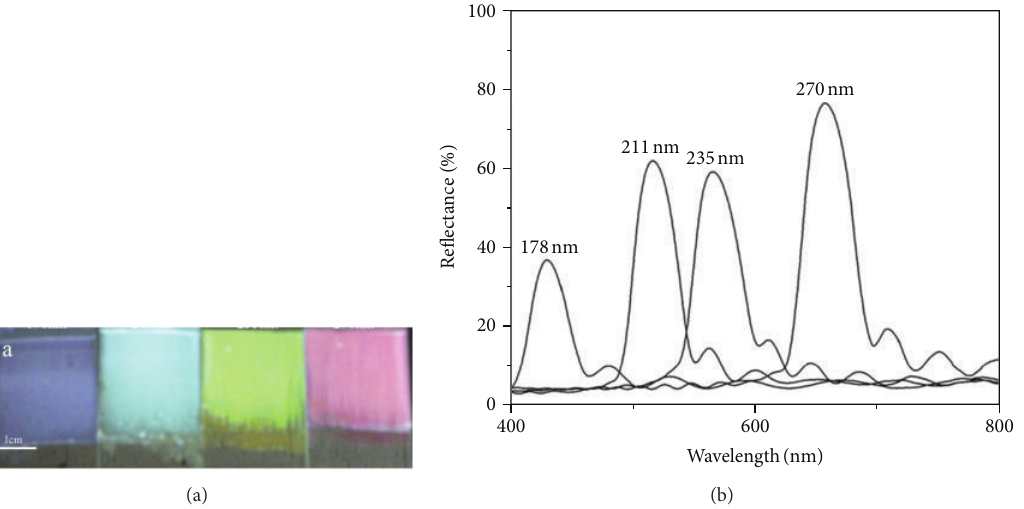
Figure 7: Polymer colloidal dispersions: (a) photograph taken at normal incidence; (b) reflection spectra [41].